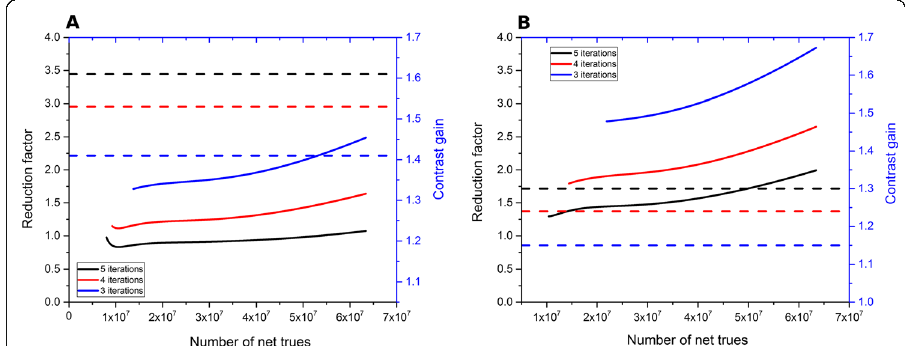
Fig. 5 Scan time reduction factor achievable when considering the reconstruction obtained with the mCT as the reference. a 440 × 440 and b 220 × 220 matrix size for the Vision (using 3 different numbers of iterations). Right y-axis and dashed lines: contrast improvement for the 10-mm sphere (blue, red, and black lines correspond respectively to 3, 4, and 5